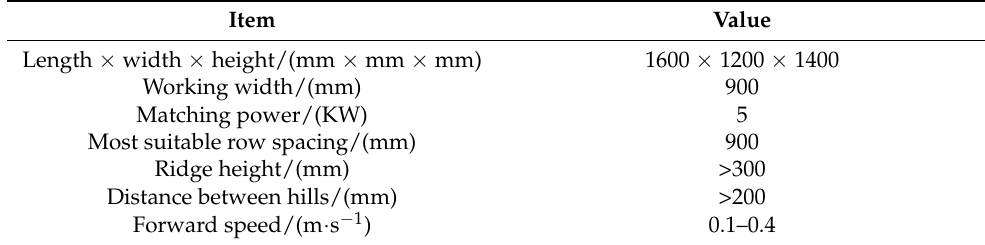
Figure 1. Structure of the entire machine. ( a ) Transplanting instructions. ( b ) Rear view. (1) Trans- planting conveyor belt; (2) gasoline generator; (3) working table; (4) tracked chassis; (5) designated location; (6) transplanting robot arm; (7) transplanting conveyor belt drive motor; (8) sweet potato seedlings; (9) brush; (10) groove; (11) replanting conveyor belt; (12) replanting robot arm; (13) chassis drive motor; (14) control box. Table 1. Structural parameters of sweet potato transplanter.